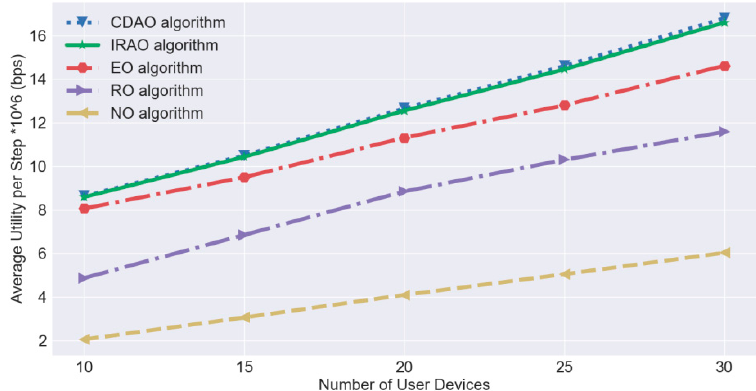
Figure 9. Algorithm effectiveness comparison of the IRAO and candidates.